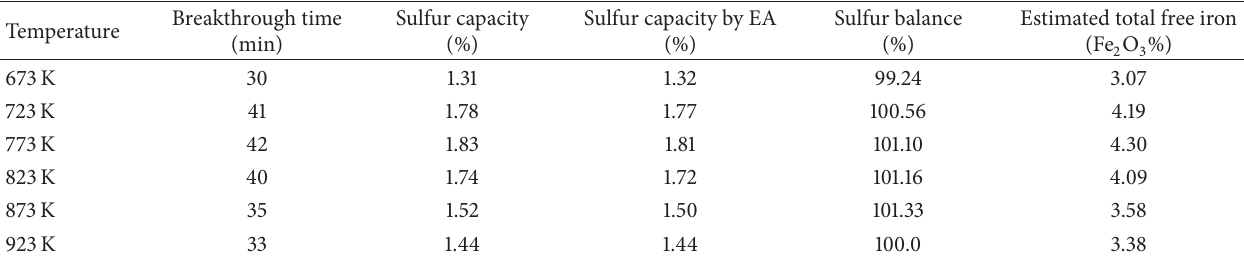
Table 3: The sulfur capacities of the Loupi soil at various temperatures under the experimental condition of 50% CO and 1% H 2 S with balanced N 2 .